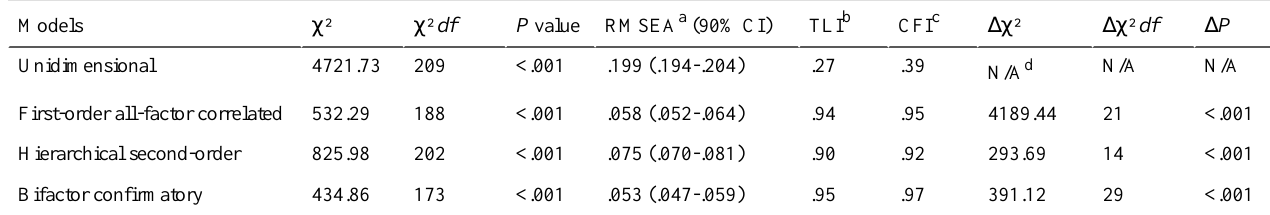
Table 2. Fit indexes of the structural equation models